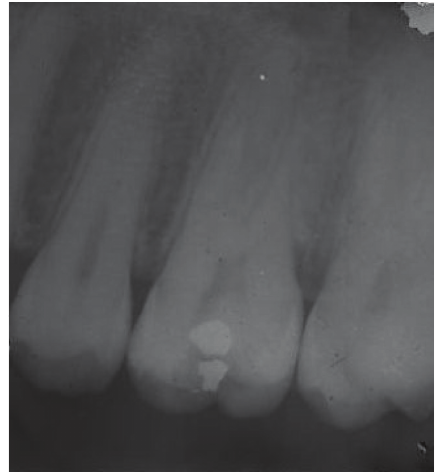
Figure 2: Radiolucent area approaching the pulp space with periodontal ligament space widening.